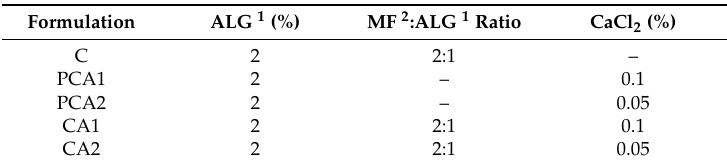
Table 1. Components of designed microparticles